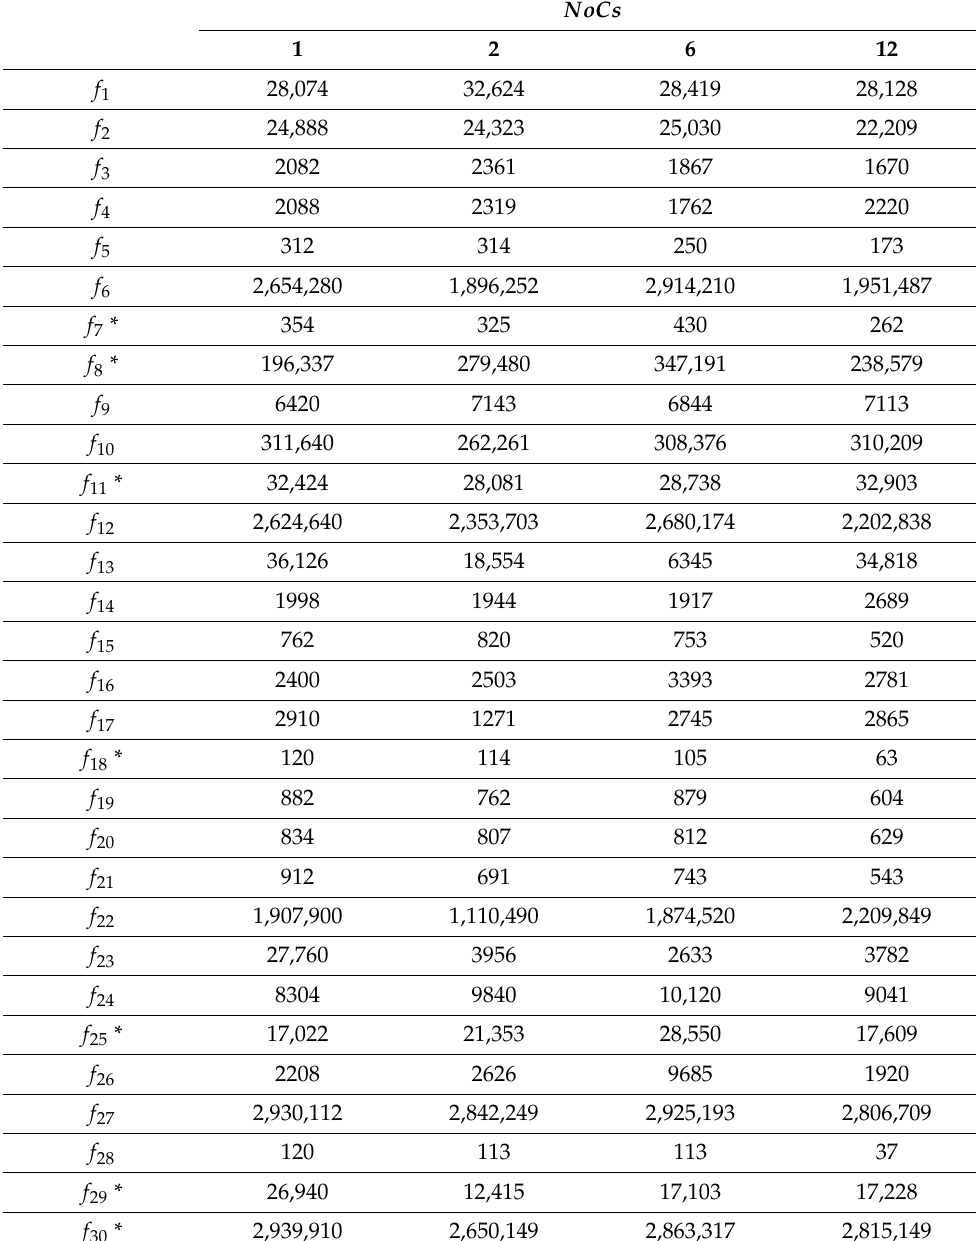
Table 10. Sharing data parallel algorithm: number of function evaluations for error <1 × 10 − 3 (* < 1 × 10 2 ). popInitSize =